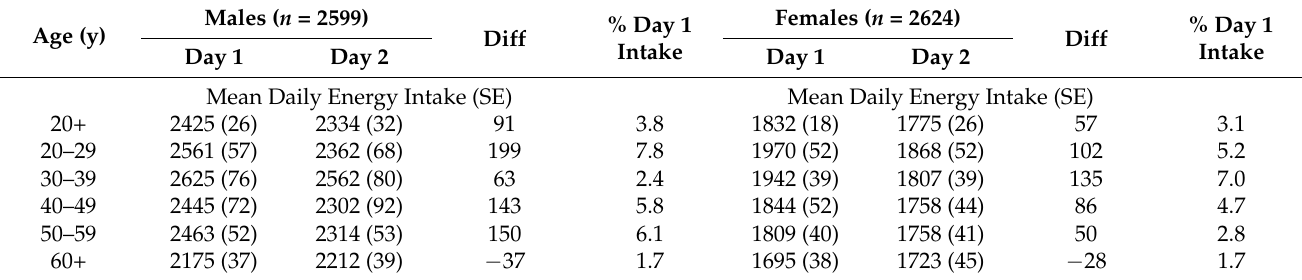
different age groups among males ranged from − 37 kcal for age 60+ to 199 kcal for age 20–29 years, and among females ranged from − 28 calories for age 60 plus to 135 kcal for age 30–39 years. These differences in energy intake between Day 1 and Day 2 correspond to 2–8% of Day 1 mean energy intake. Table 4. Mean daily energy intake by sex, age, and intake day for U.S. adults age 20+, WWEIA, NHANES 2013–2016 1 . Age (y)